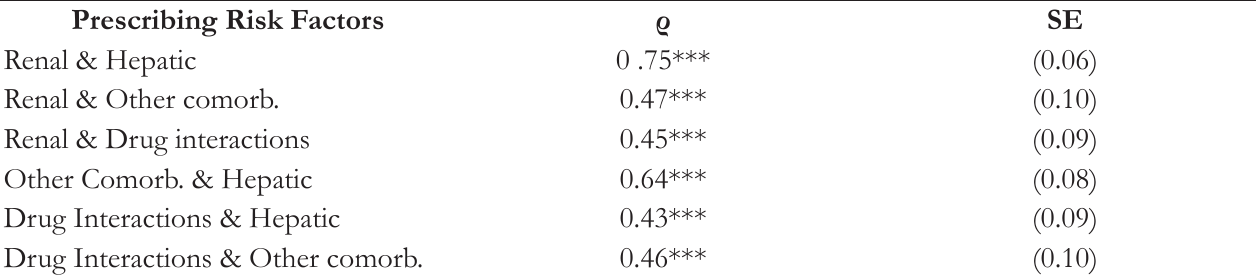
Table 3. Variance/Co-variance Matrix of the Risk Factors Prescribing Risk Factors ρ SE Renal & Hepatic Renal & Other comorb. Renal & Drug interactions Other Comorb. & Hepatic Drug Interactions & Other